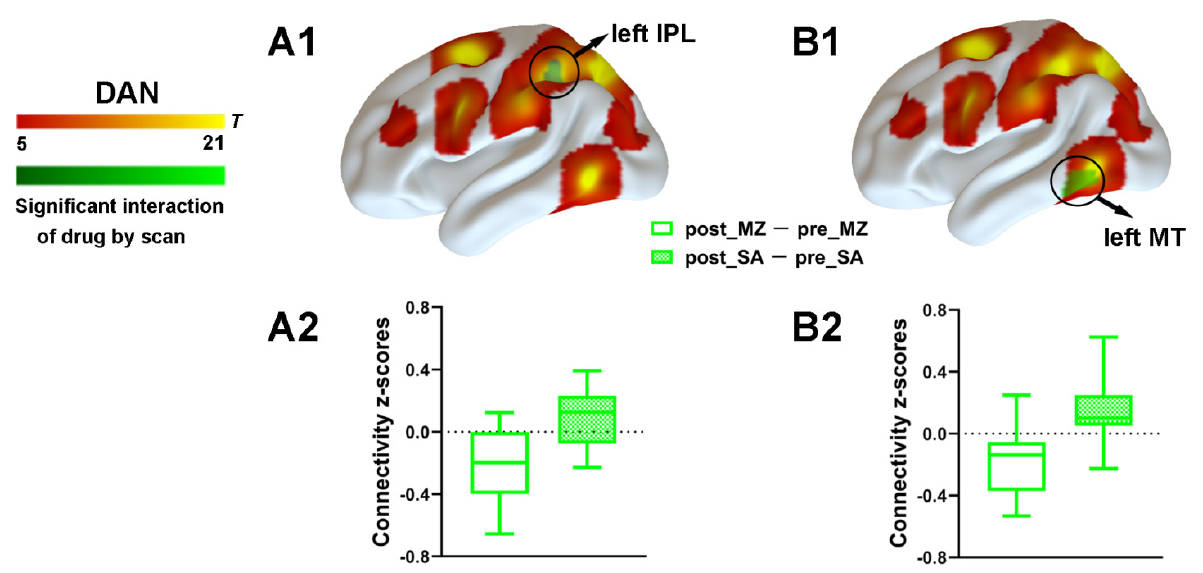
Figure 4. Spatial differences in functional connectivity within the DAN by midazolam injection. Two-way repeated measures ANOVA revealed significantly decreased positive functional connectivity (in green) by midazolam injection between regions predefined as pertaining to DAN and the left IPL ( A1 ) and left MT ( B1 ). Significant results are overlaid on the spatial maps (shown in warm yellows) of the DAN (cluster-level FWE correction). ( A2 ) Functional connectivity of the post_MZ-pre_MZ and the post_SA-pre_SA within left IPL of the DAN that showed significant interaction between drug and injection measurements among volunteers under each condition. ( B2 ) Functional connectivity of the post_MZ- pre_MZ and the post_SA-pre_SA within left MT of the DAN that showed significant interaction between drug and injection measurements among volunteers under each condition. Boxplot whiskers indicate min and max. Box is defined by 25th percentile, median, and 75th percentile. Bars represent average functional connectivity strength ( z -values), and error bars indicate standard error (SE) derived from the ANOVA test on the cluster that showed significant interaction between drug and injection measurements. Abbreviations: IPL, inferior parietal lobule; MT, middle temporal area; DAN, dorsal attention network; MZ, midazolam; SA, saline.